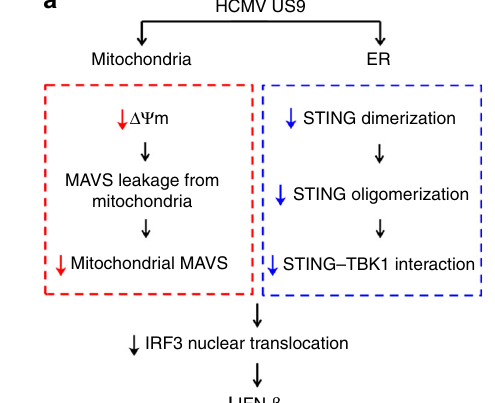
Fig. 6 HCMV US9 inhibits MAVS- and STING-mediated IFN- β signaling. a US9 expression in HCMV WT-infected HFF cells. HFF cells were infected with HCMV WT at a multiplicity of infection (MOI) of 2. After incubating the infected cells for the indicated number of days post-infection (dpi), total RNA